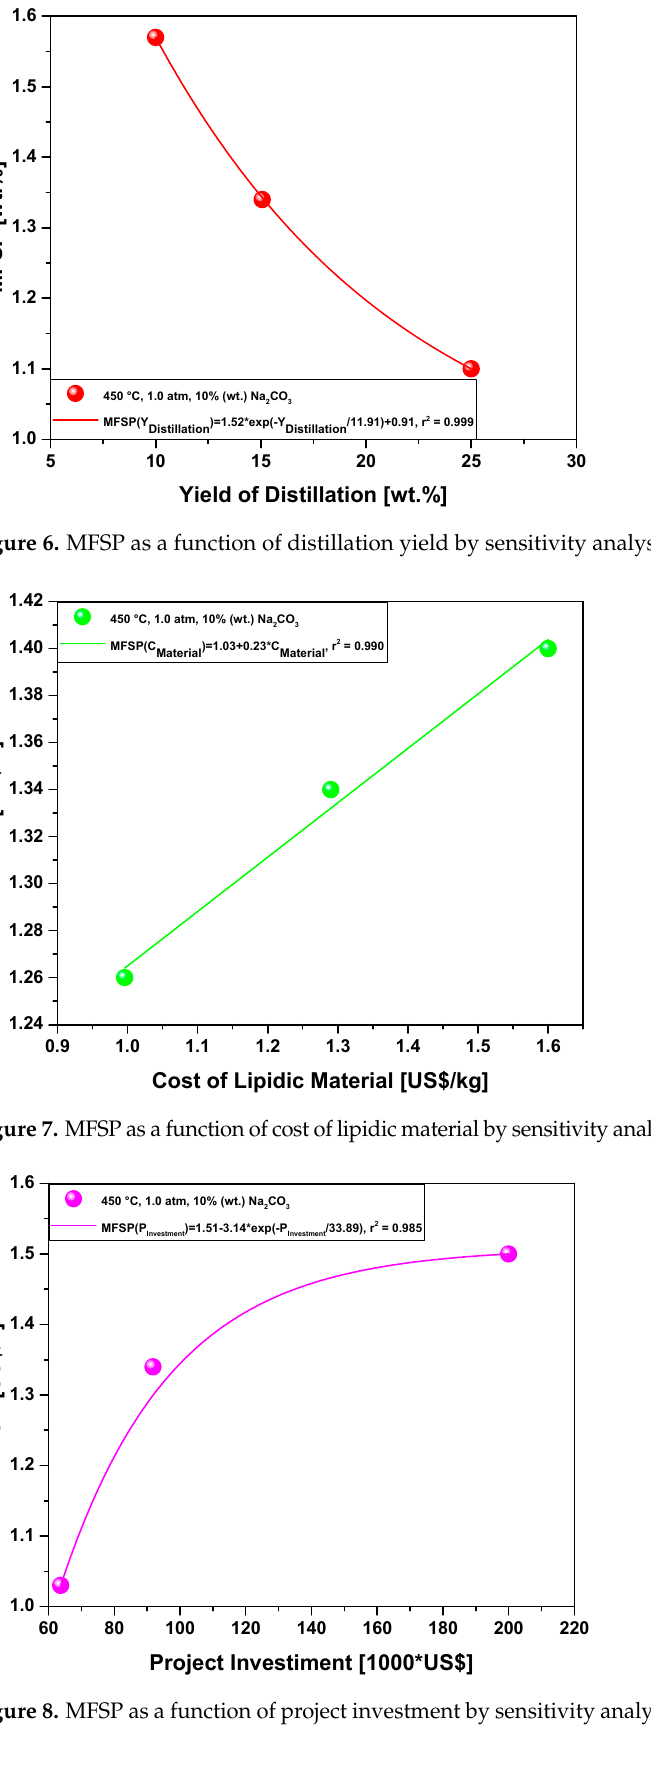
Figure 8. MFSP as a function of project investment by sensitivity analysis for a 450 L/day production. Operation cost, payback period (PBP), and breakeven analysis are used to investigate the relationships between the planned project cost and the rate of return. The breakeven point (BEP) is the point at which total cost and total revenue are equal, which means there is a balance of the profit and loss [28]. Table 6 presents the cash flow in which the total cost is equal to the total revenues and corresponds to nil in the fifth year of cash flow. The value of MFSP obtained was 1.30 US$/L.